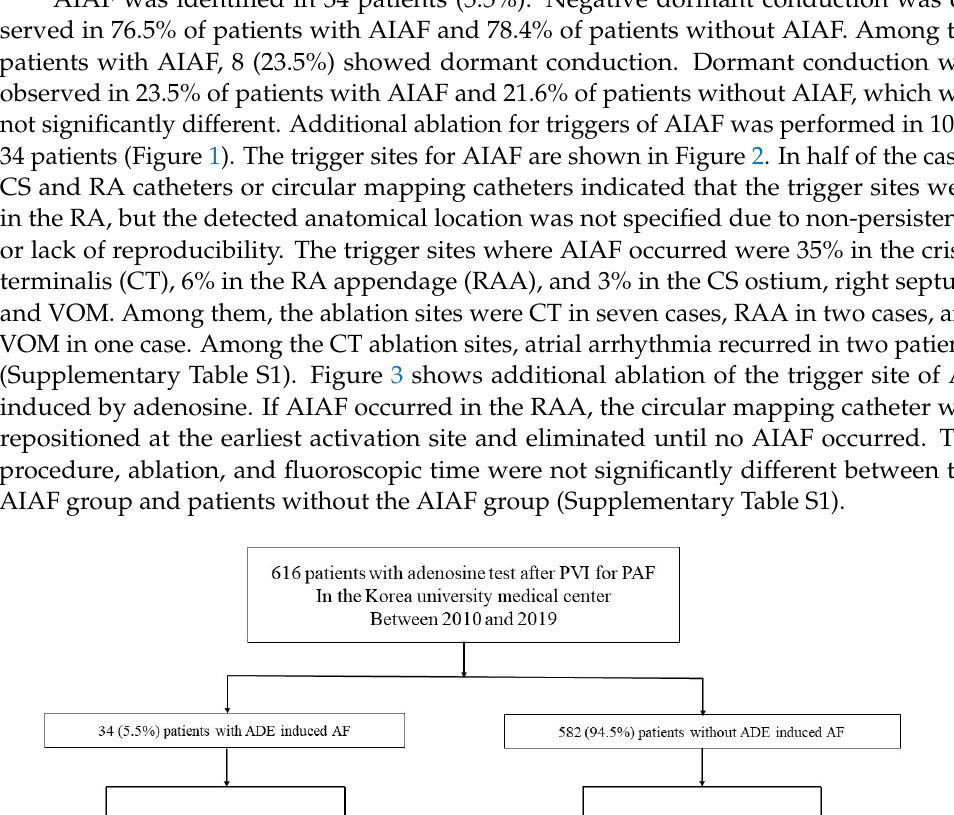
Figure 2. Trigger sites of adenosine ‐ induced atrial fibrillation and recurrence rate after ablation of trigger site. RAA = right atrial appendage; CS os = crista terminalis ostium; VOM = vein of Marshall unspecified. The trigger sites were unspecified, but CS and RA catheters or circular mapping cath ‐ eters indicated that RA was the trigger site.